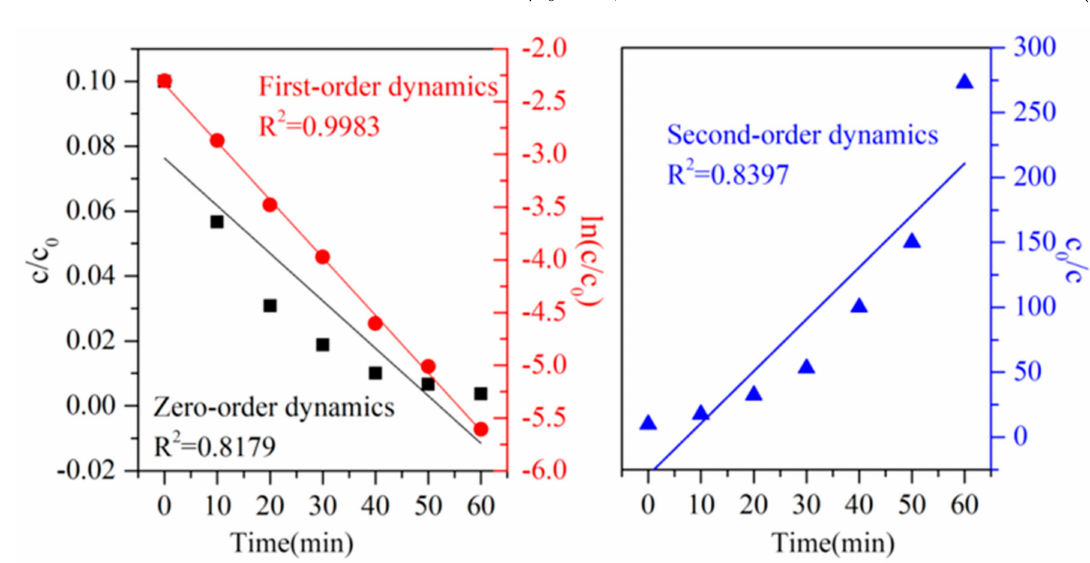
Figure 1. Kinetic simulation of degradation of benzothiazole ILs; [C 4 BthPF 6 ] = 0.1 mM, t = 45 ◦ C, pH = 5.06, [H 2 O 2 ] = 100